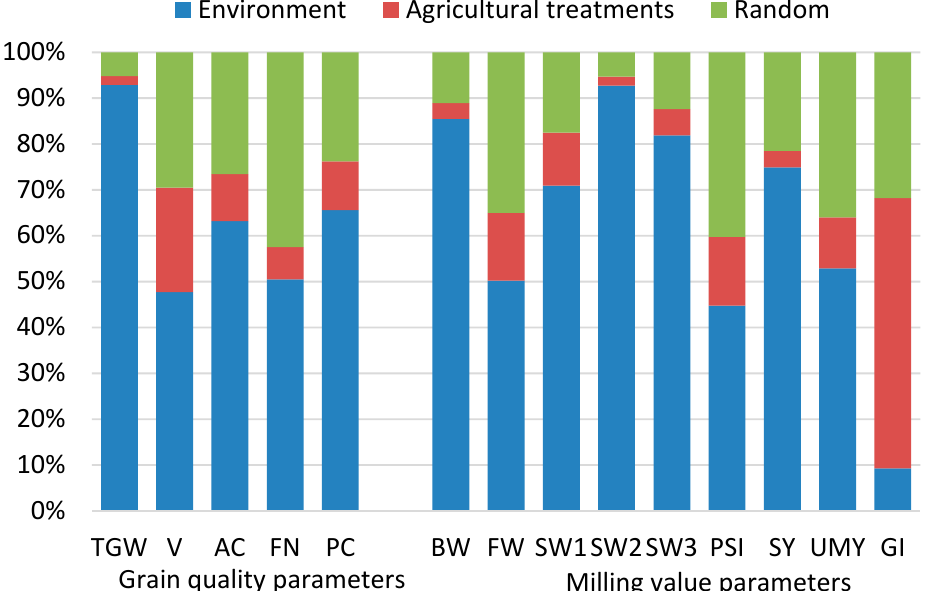
Figure 2. Percentage contribution of environmental, agronomic, and random factors to total variance in grain quality and milling value parameters. Refer to Table 1 for the key and to Table S2 in the Supplementary Material for the sums of squares used in the calculation of eta-squared. Table 3. Comparison of treatment means for grain quality and milling value